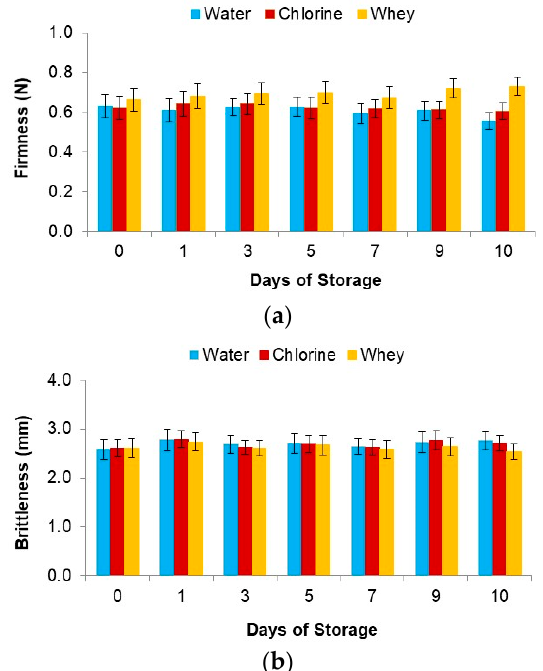
Figure 4. Firmness ( a ) and Brittleness ( b ) of the lettuce after sanitizer treatments, over 10 days in cold storage. Results represent the average of at least three replicate experiments (n = 3) ± SD.